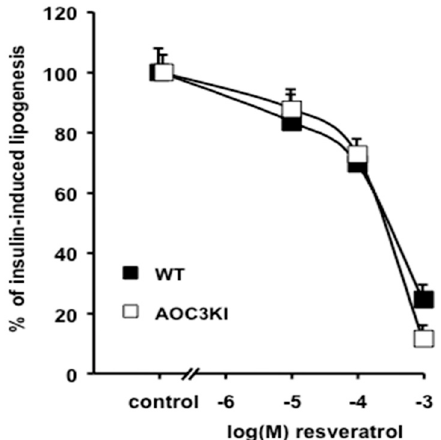
Figure 4. Dose-dependent inhibition of glucose incorporation into lipids of mouse adipocytes . Lipogenic activity was measured during a 120 min period, via the incorporation of 3 H-glucose into lipids of native adipocytes from wild-type (WT, black squares) or SSAO-invalidated mice (AOC3KI, open squares). The x axis represents the logarithm of the molar concentration (M). Data as a percentage of 100 nM insulin activation of glucose incorporation into adipocyte lipids (control). Each point is the mean ± SEM of 5–10 preparations. No significant gene effect was detected.